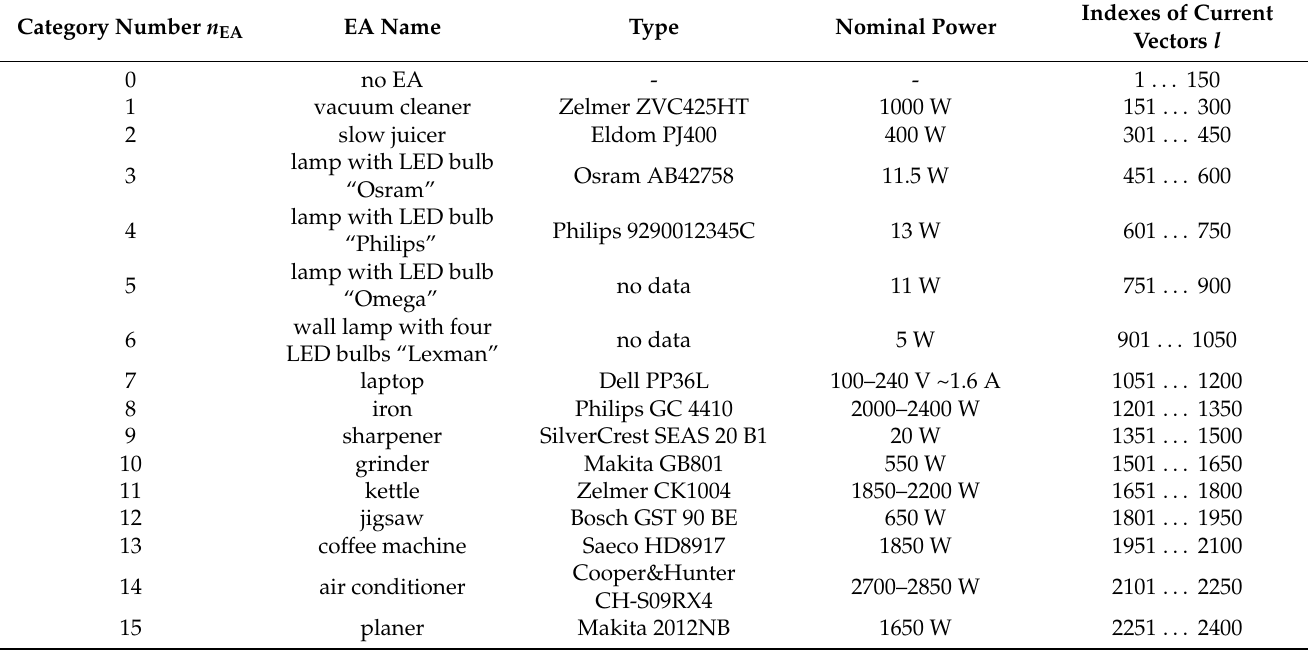
Table 2. Each current vector i has 300,000 samples (representing duration of 10 ms). Table 2. Information on recorded current